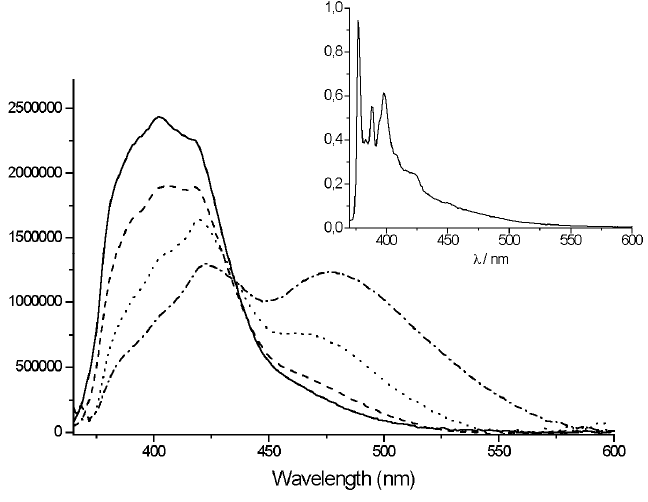
in THF ( ___ ), in valeronitrile (---), in Figure 5. Emission spectra of TpyPhPyrene 2 propionitrile ( ··· ) and in acetonitrile ( − · − ) at room temperature (inset: spectrum at 77K in = 310 butyronitrile matrix) (  ex